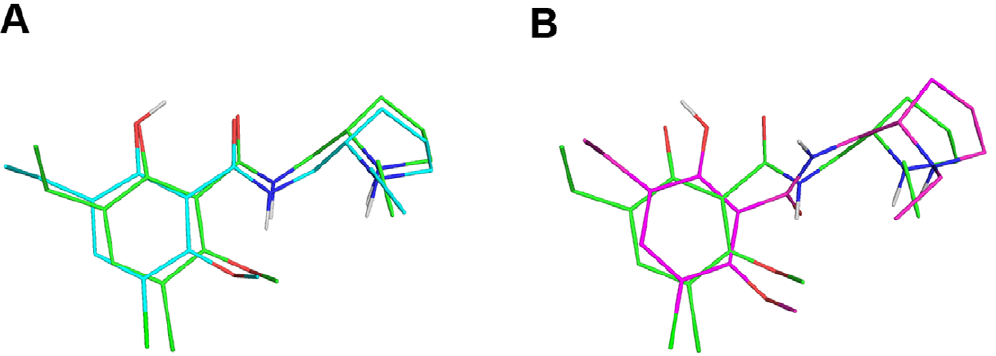
Figure 2. Re-docking eticlopride. Superimposition of eticlopride re-docked with AD4.2 (cyan lines, A) and with Vina (magenta lines, B) toward eticlopride in complex with hD 3 in the crystal structure 3PBL (green lines).